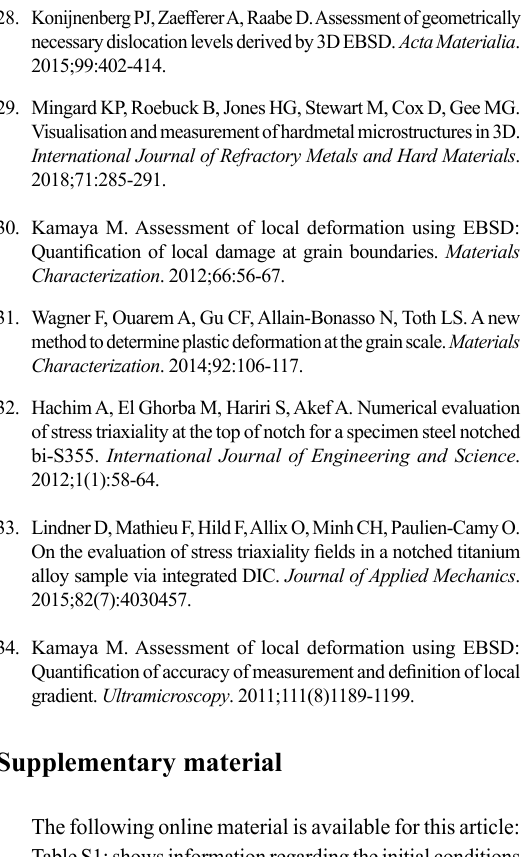
Figure S1: Misorientation profiles obtained from GBs AE - BE and BE - DE. Figure S2: Permeability factors corresponding to GBs AE - BE and BE - DE. Figure S3: IPF maps obtained from the closest zone to EZ inside the notch (nEZ). Figure S4: Misorientation profiles obtained in selected GBs in nEZ. Figure S5: Permeability factors obtained for GBs in